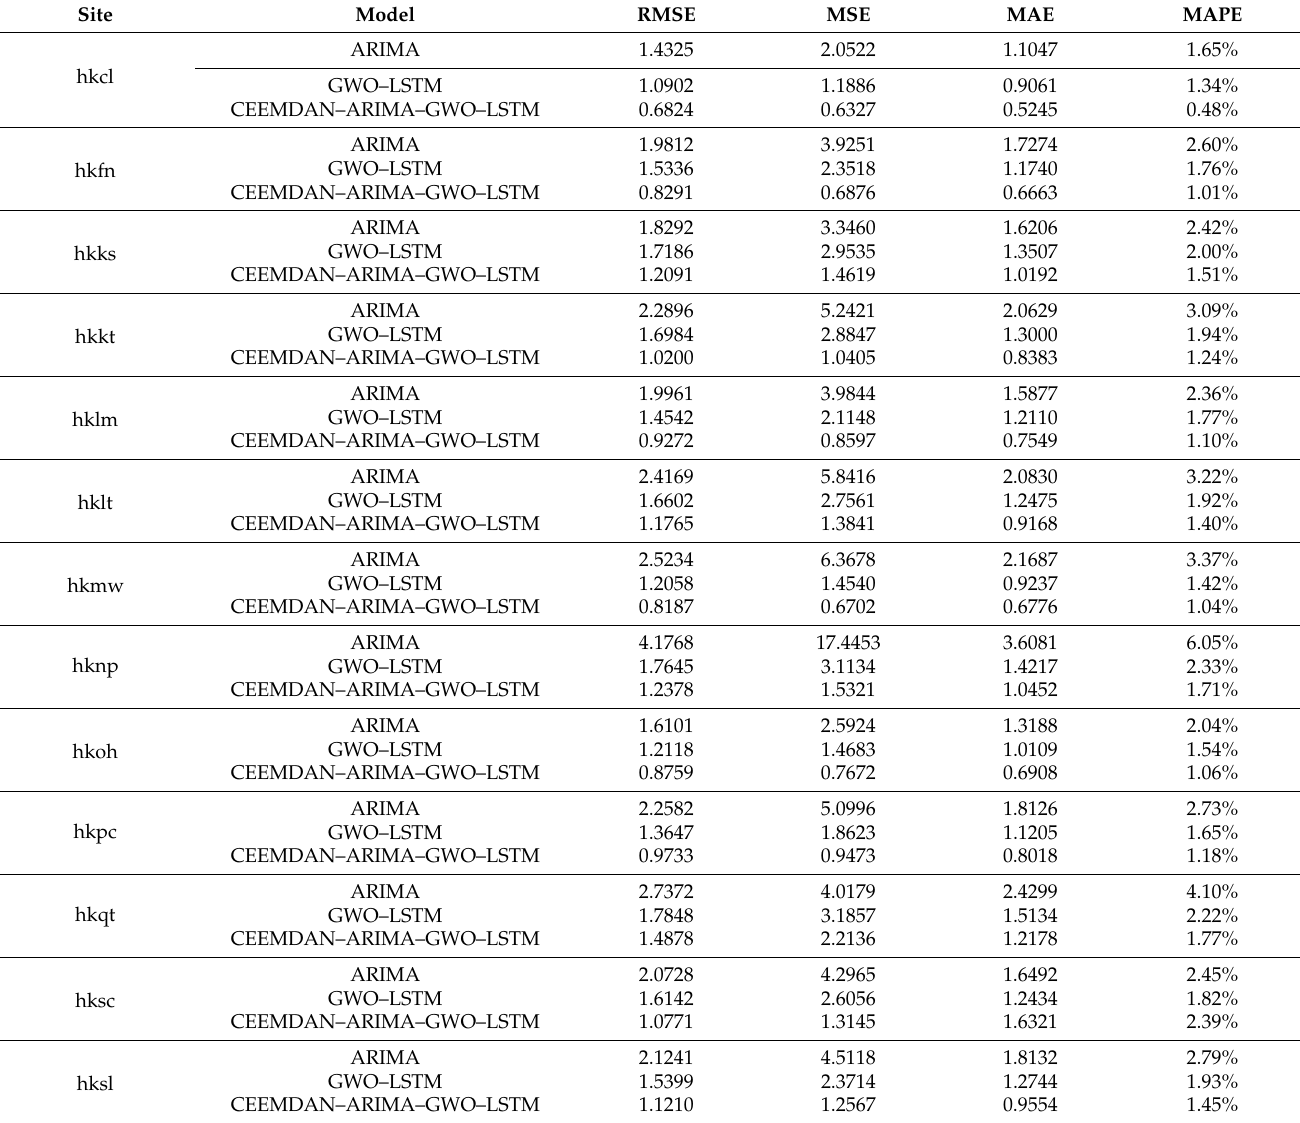
Table 3. Model error values of each